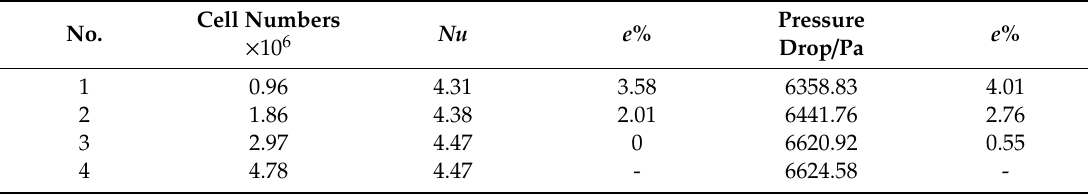
Table 1. Grid independence